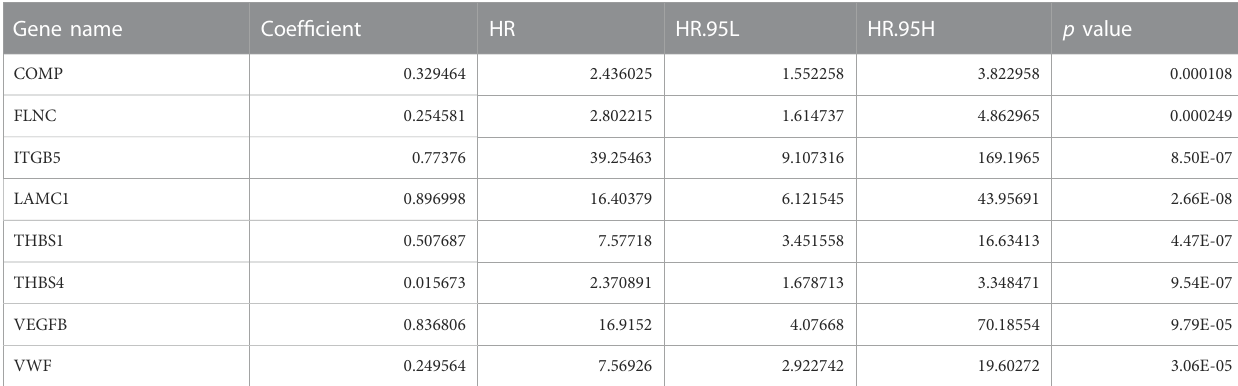
TABLE 2 Details of the eight focal adhesion-related genes in the prognostic